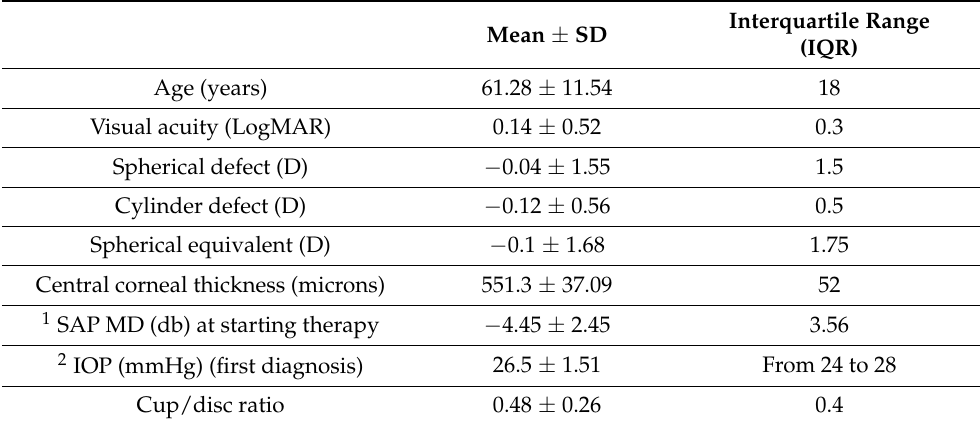
Table 1. Main ocular characteristics of the 190 patients included in the